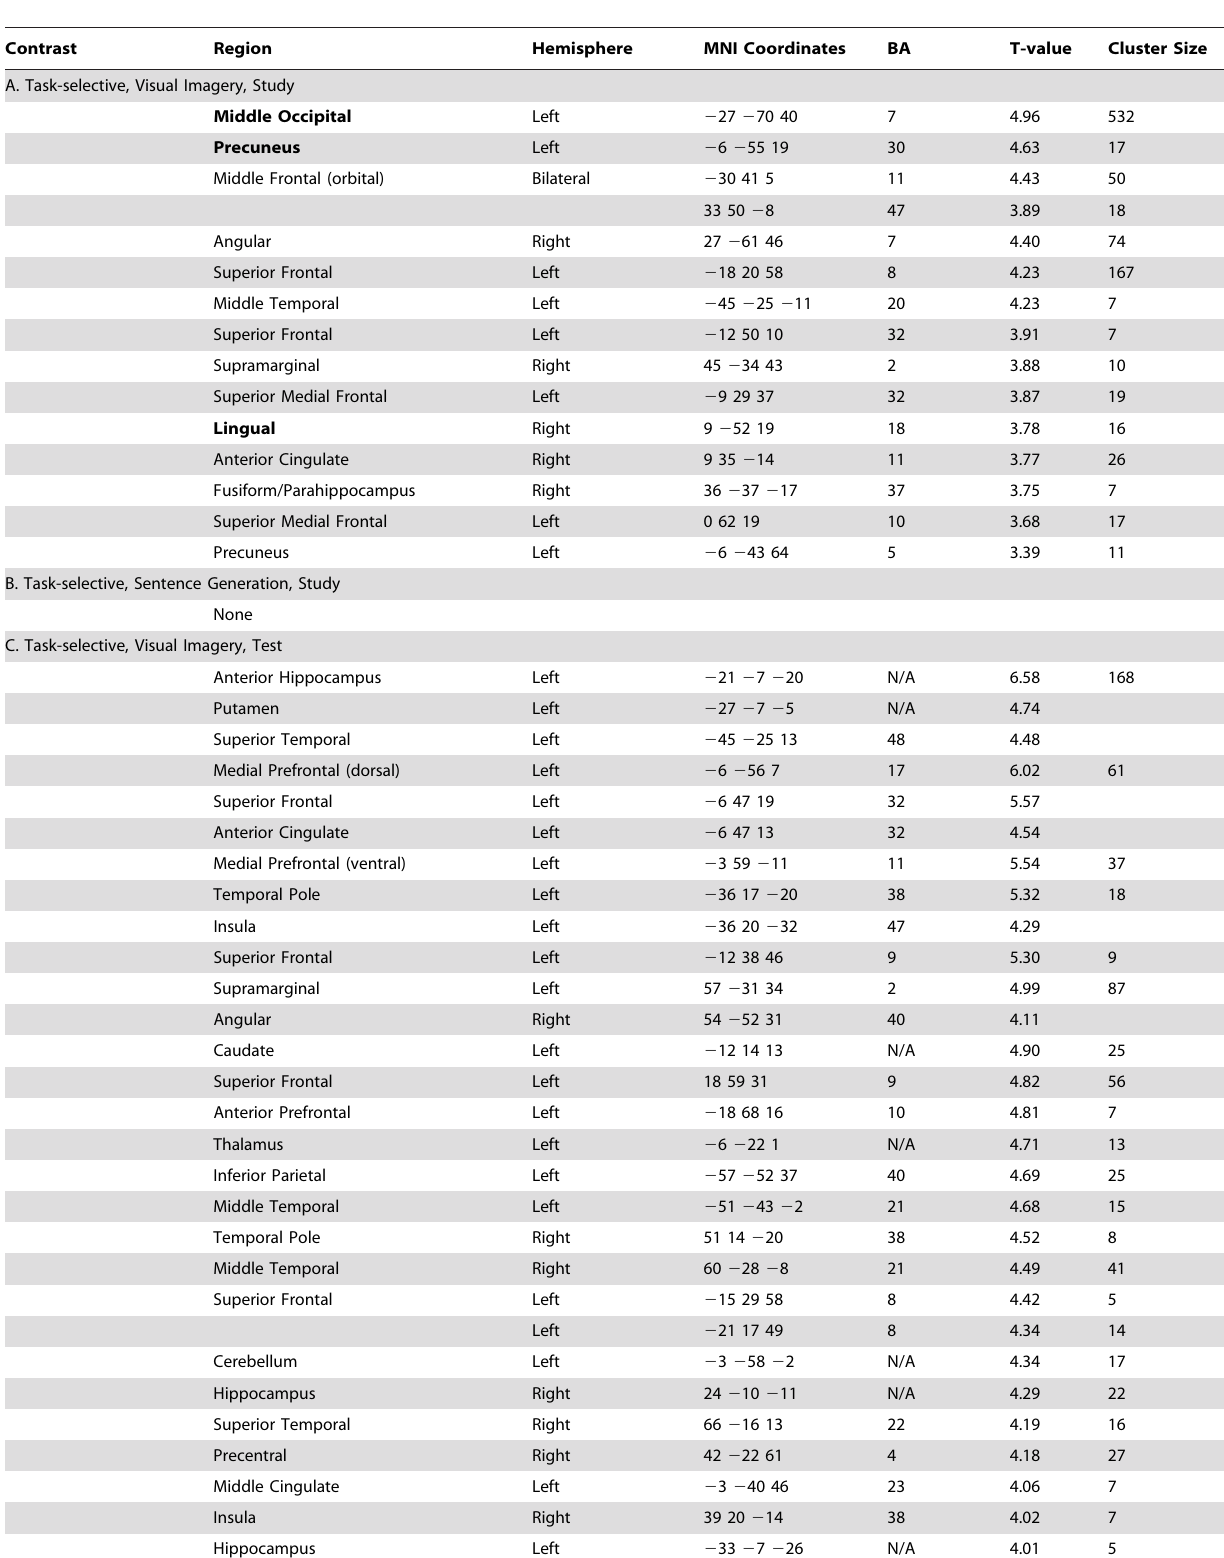
Table 3. Regions showing task-selective memory effects for the visual imagery (A) and for the sentence generation condition (B) at the time of study